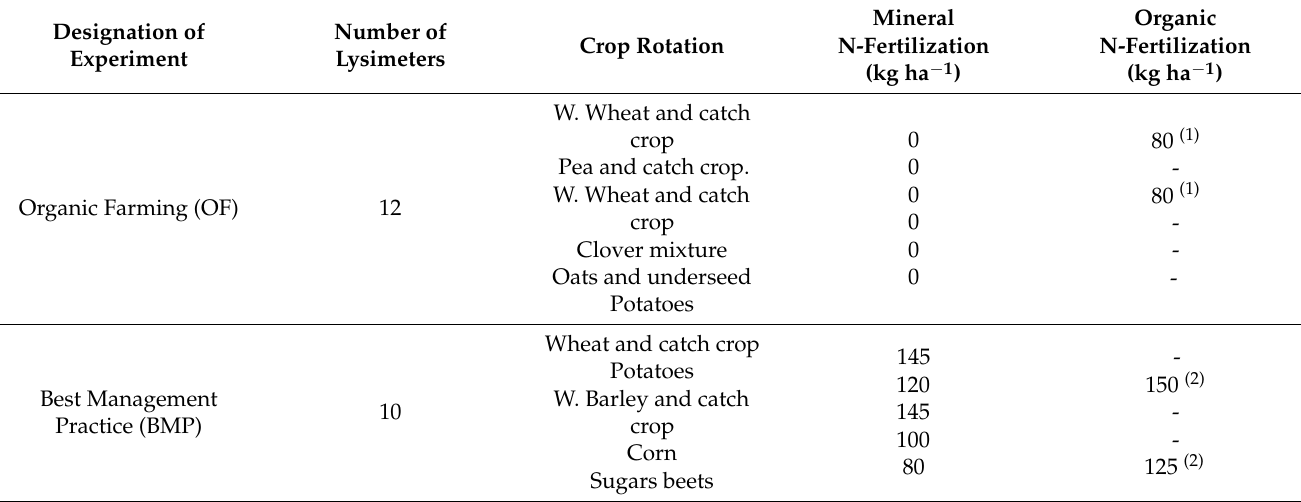
Table 2. Overview on the experimental lysimeter management practices and fertilization (W. = winter).